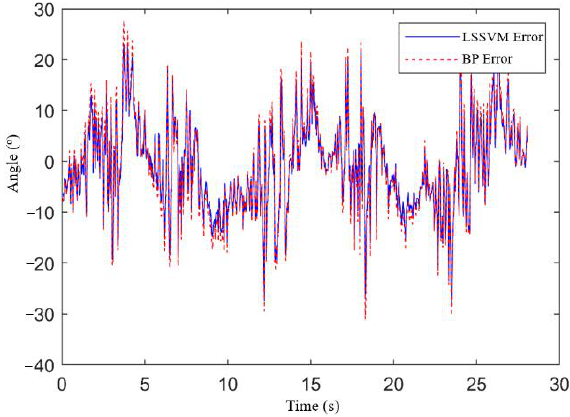
Figure 5. Prediction error comparison with different methods.